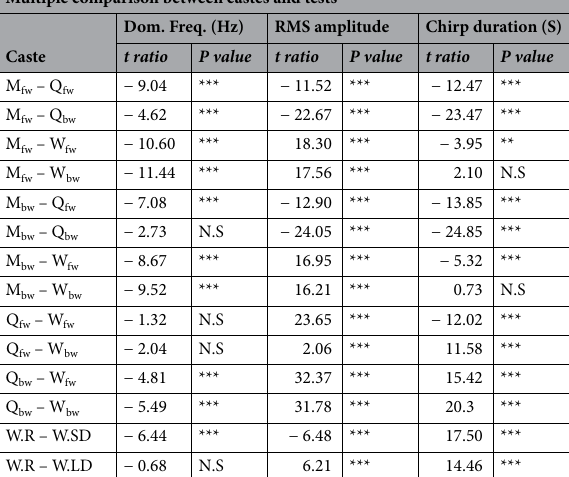
Table 2. Multiple comparison among caste and between worker signals emitted in the two different contexts. M fw and M bw male forward and backward chirps, Q fw and Q bw queen forward and backward chirps, W fw and W bw worker forward and backward chirps, W.R worker restrained chirps, W.SD worker chirp with small food drop, W.LD worker chirp with large food drop, N.S. not significant (P > 0.05), ***P <